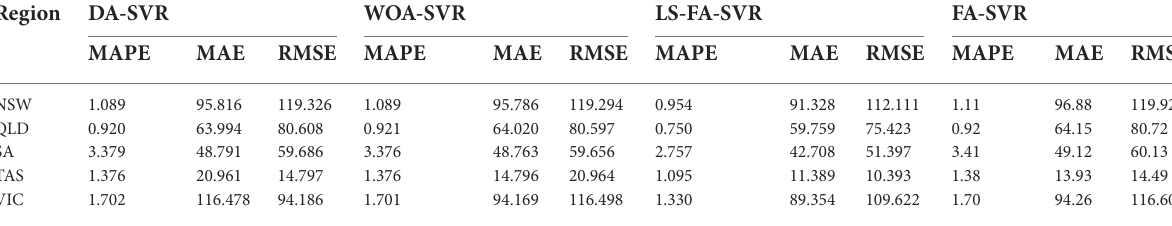
TABLE 5 PerformanceoftheLS-FA-SVRbasedonMAE,MAPE,andRMSEcomparedtoothermodels. Region DA-SVR WOA-SVR LS-FA-SVR FA-SVR MAPE MAE RMSE MAPE MAE RMSE MAPE MAE RMSE MAPE MAE RMSE